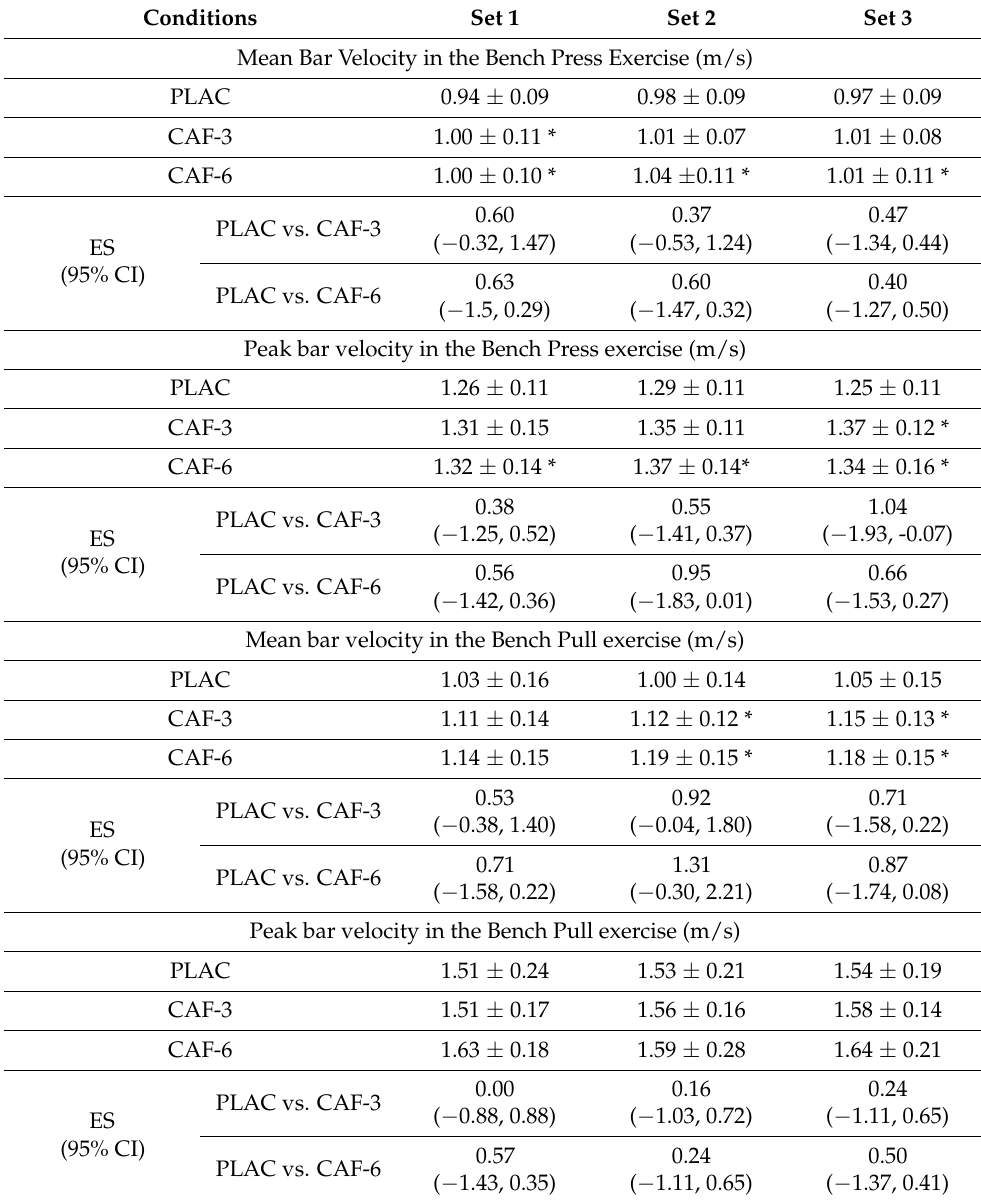
Table 2. Peak and mean bar velocity for each set of the three sets of the bench press and bench pull exercises with the ingestion of 3 and 6 mg/kg of caffeine or with a placebo. Conditions Set 1 Set 2 Set 3 Mean Bar Velocity in the Bench Press Exercise (m/s)